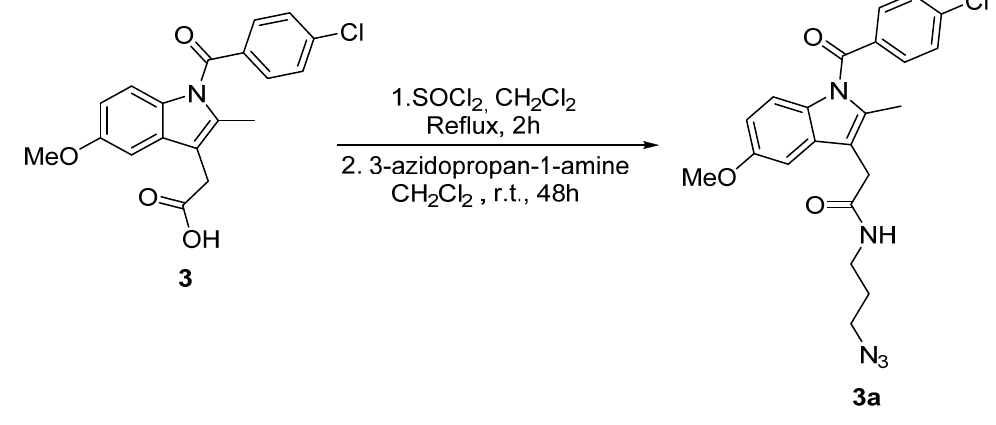
Scheme 4. Synthesis of indomethacin derivative 3a